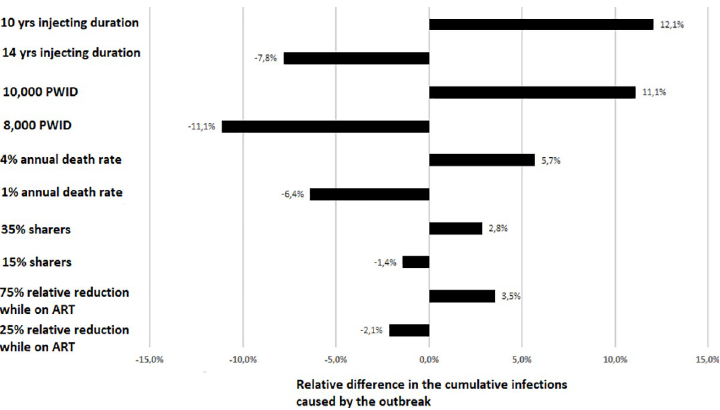
Fig 3. Results of one-way sensitivity analysis showing the relative difference in the cumulative number of new infections caused by the outbreak compared to the base parameter values in Table 1. A value of zero describes no change from the projected cumulative incidence. A positive or a negative value means that the projected incidence is higher or lower, respectively, compared to that projected under the base scenario.